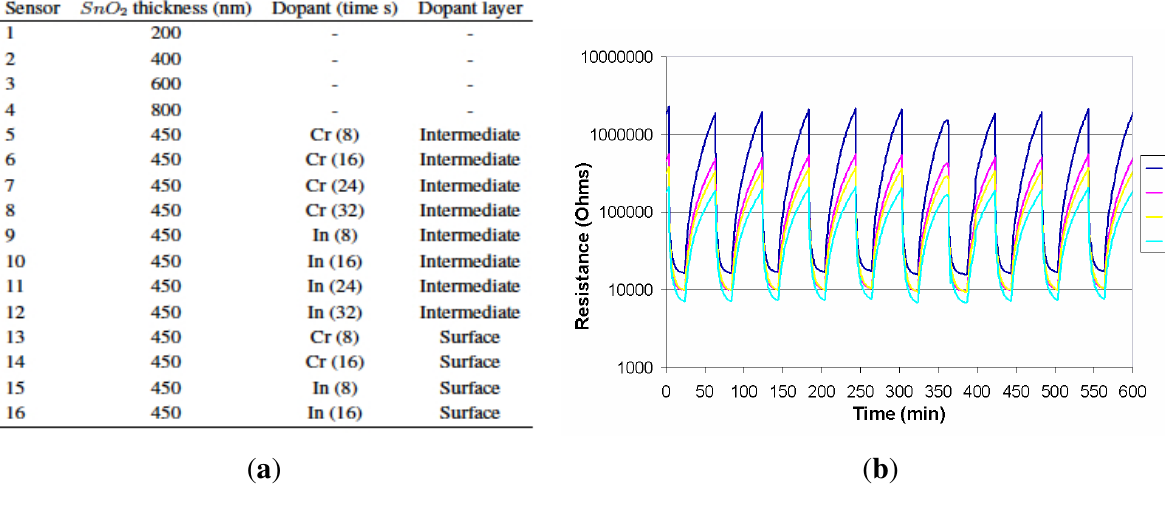
Figure 2. Typical transient response and doping characteristics of the gas sensors. ( a ) Sensor array composition; ( b ) Typical transient response of four sensors of the